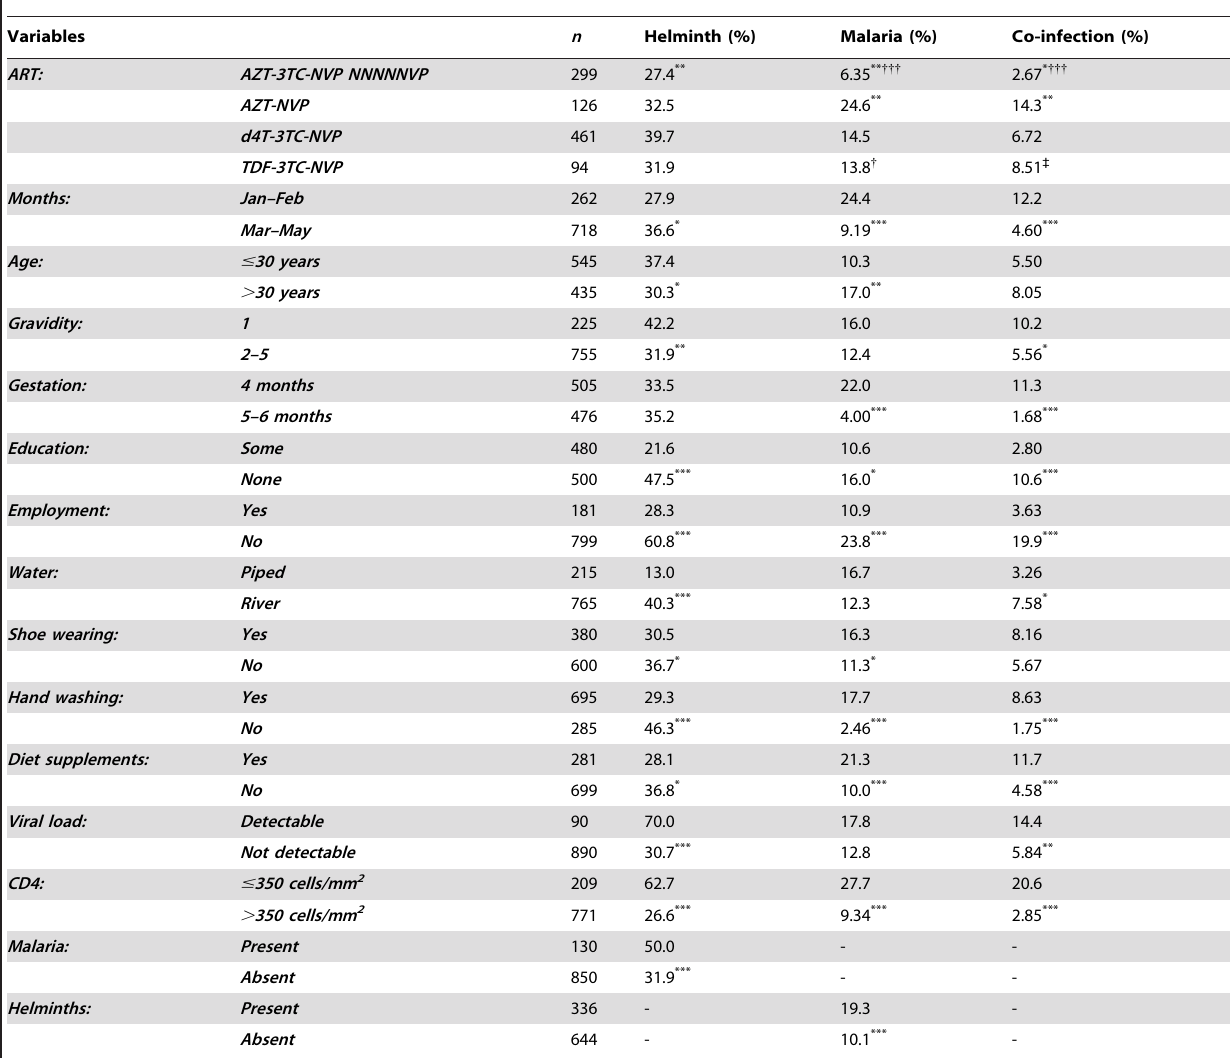
Table 2. Prevalence of helminth and malarial infections in relation to various risk factors.